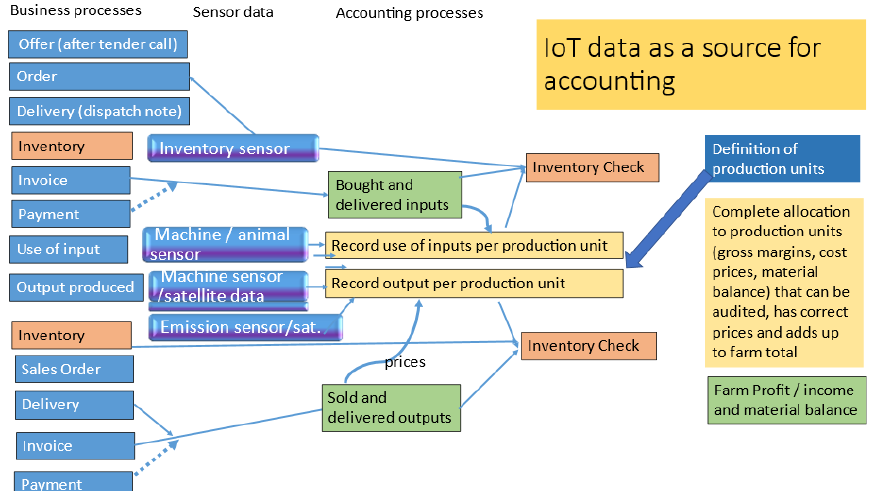
Figure 5. How IoT data can be integrated with Farm Financial Accounting and Farm Management